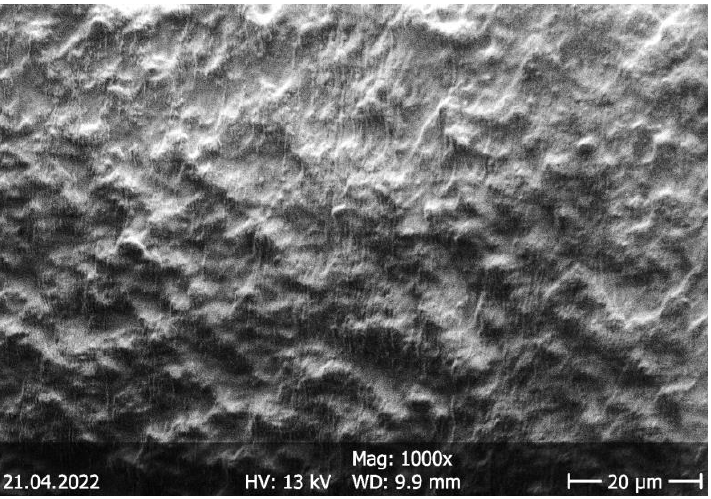
Figure 6. Scanning electron microscopy (SEM) image of HT–PLA.